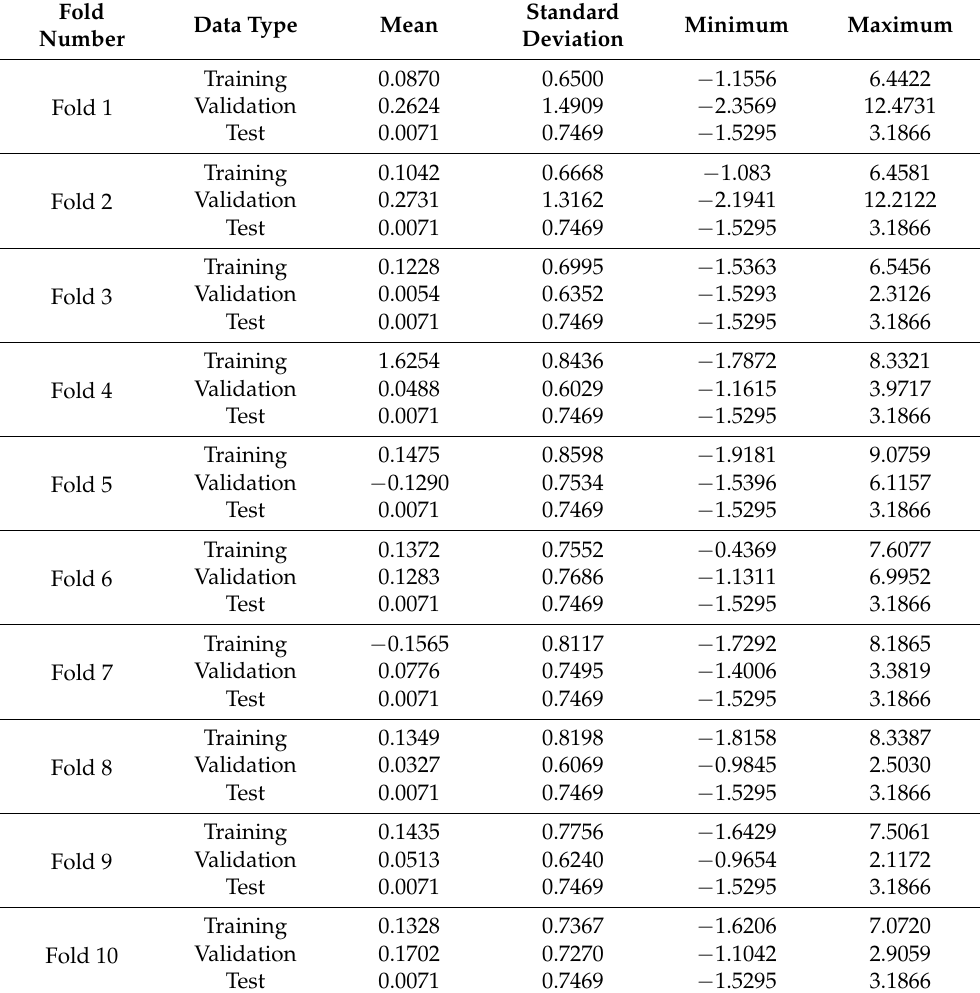
Table 3. Range of scaled data in each fold of the 10-fold